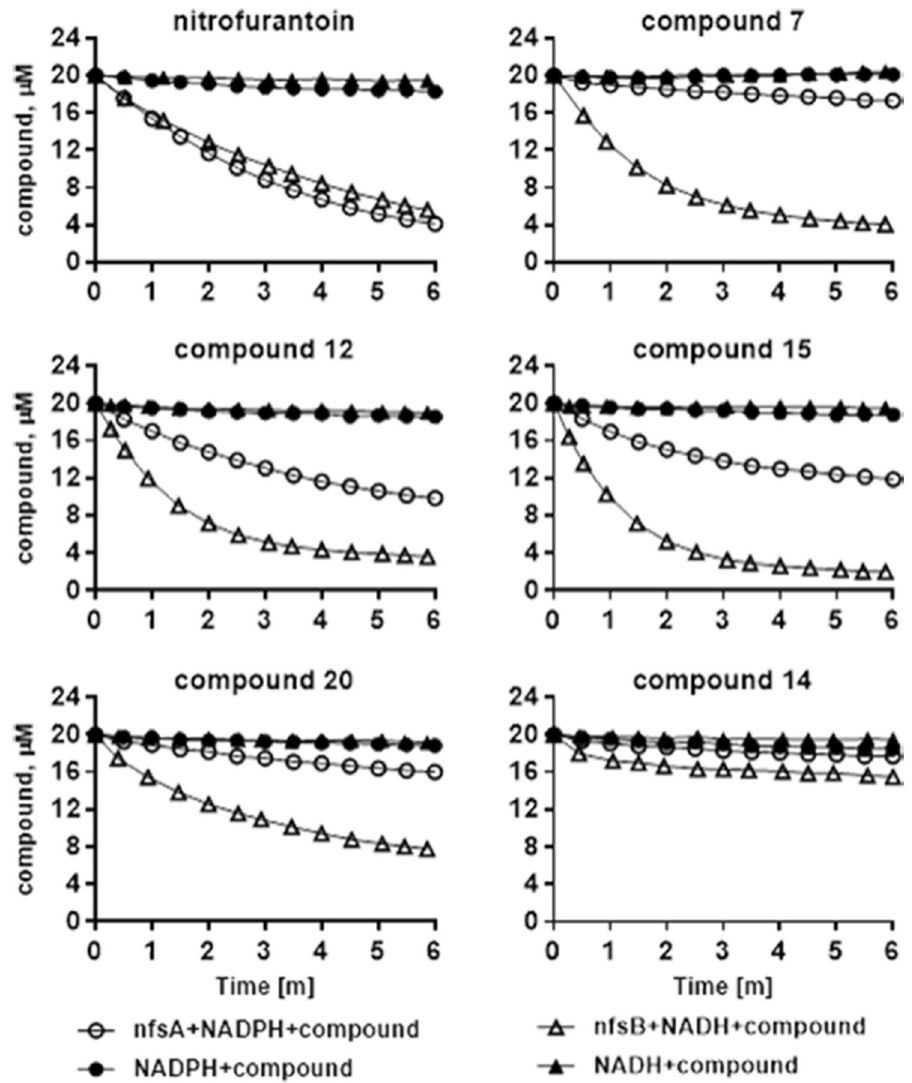
Figure 5. NfsB and NfsA nitroreductase enzyme activity, the reactions are initiated with 40 µ M of co-factor NADPH and NADH respectively. The depletion of the co-factor is monitored in a fluorescence assay that is used to measure the reduction of the compounds 7, 12, 15, 20, and 14 along with a positive control nitrofurantoin over a period of 6